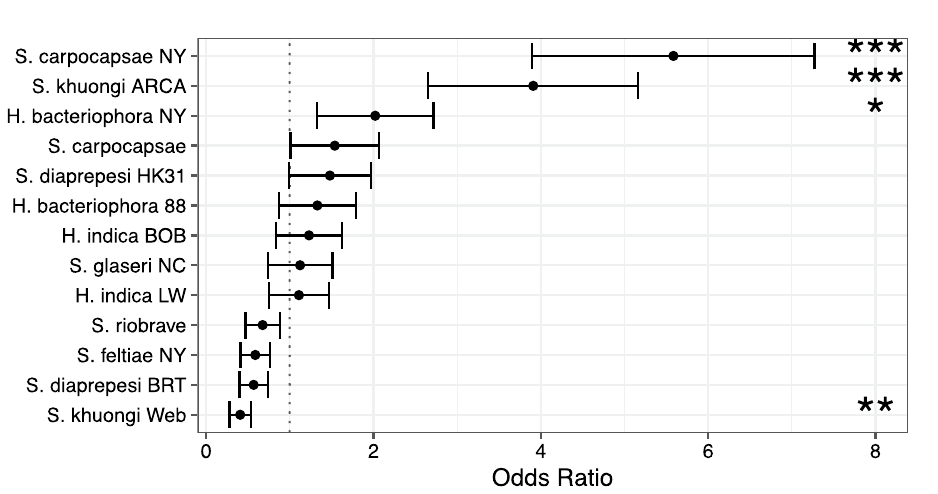
Figure 4. Odds of adult mortality following exposure to EPN strains as a pupa based on comparison to paired controls. Odds ratios significantly greater than 1 indicate and fold increase in probability of mortality. For example, adult D. antiqua exposed to S. carpocapsae NY as a pupae were 5 times more likely to die than paired controls under the same conditions who were not exposed. Odds ratios not significantly different than one indicate no change in odds of dying. Odds ratios significantly less than 1 (as is the case with S. khuongi Web indicate that exposure to entomopathogenic nematodes decreased the odds of dying. Points and error bars denote mean odds ratios and standard error respectively. Asterisks (*, **, and ***) denote a significant difference from 1 at p < 0.05 , p < 0.01 , and p < 0.001